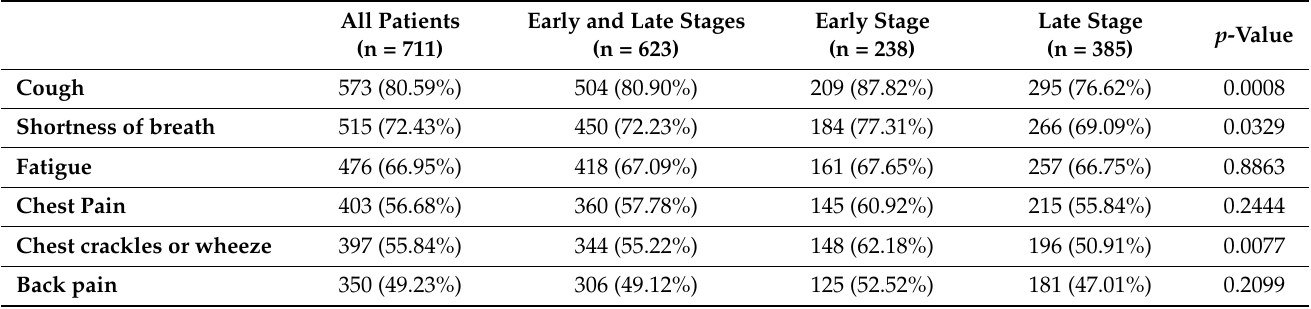
Table A4. Comparison of frequency of clinical features in the 2 years prior to diagnosis between early (Stages I, II) and late (Stages III, IV) lung